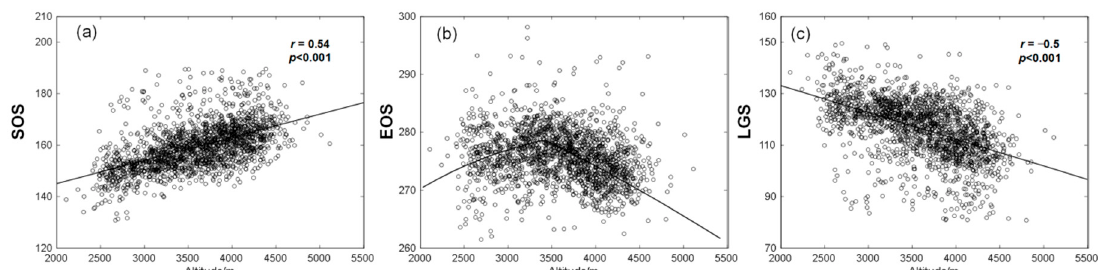
Figure 8. The relationship between phenology and altitude in the Qilian Mountains. ( a ) Relationship between the SOS and altitude; ( b ) relationship between the EOS and altitude; ( c ) relationship between the LGS and altitude.